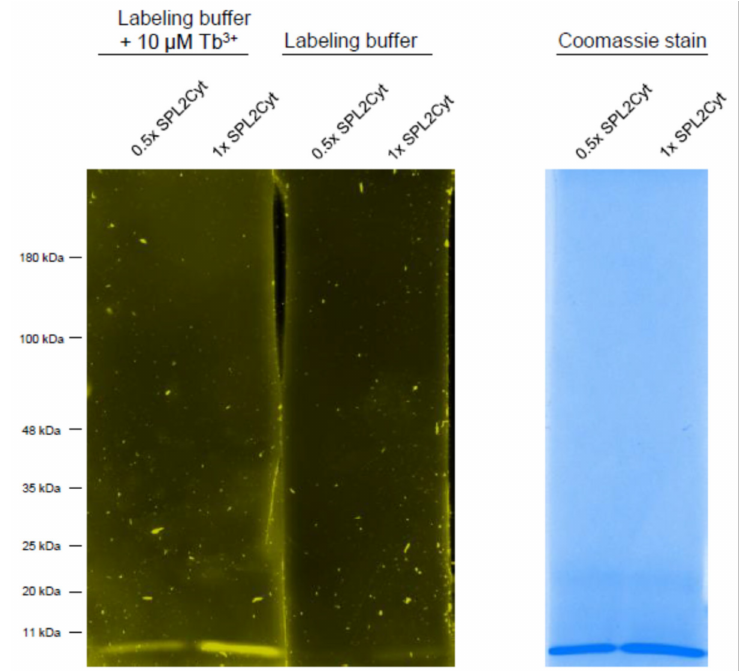
Figure A2. Visualization of the SPL2cyt protein after SDS-PAGE after incubation with Tb 3+ or Coomassie